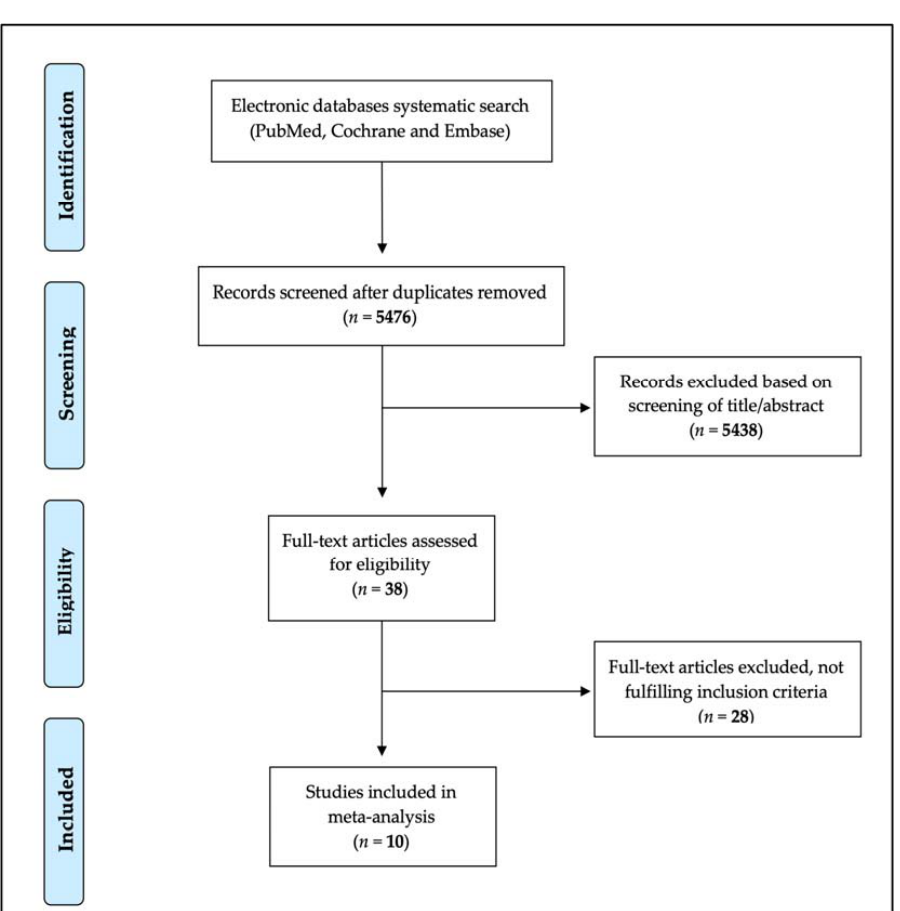
Figure 1. Study selection process (PRISMA Flow